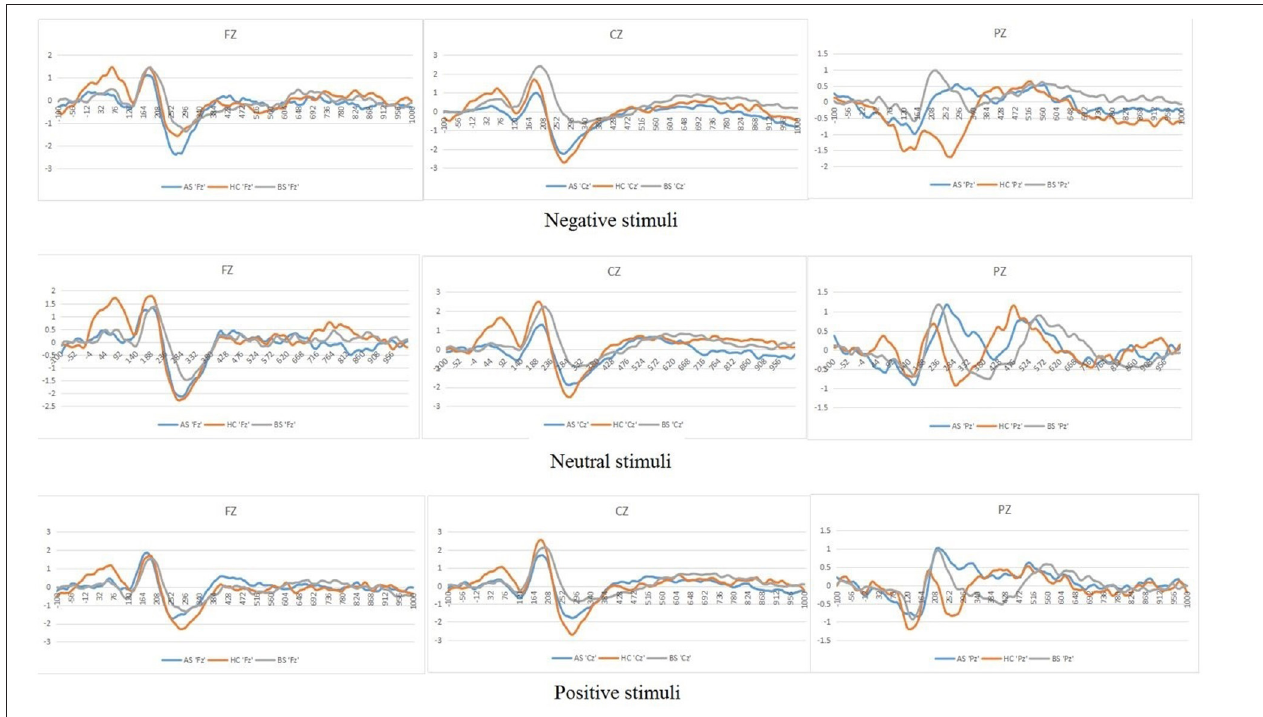
FIGURE 3 | Grand mean ERPs in each emotional stimuli and neutral stimuli at the midline electrodes (Fz, Cz, Pz) with time window of P200 for three groups (AS or postoperative group, BS or preoperative group, HCs or Healthy controls).